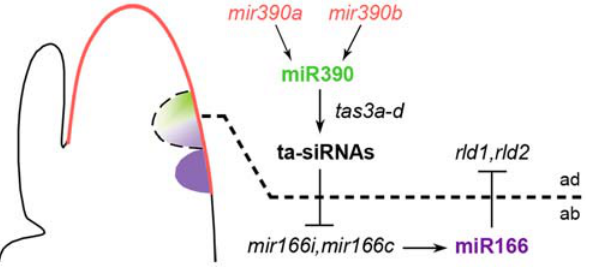
Figure 5. A model for the establishment of maize leaf polarity. The diagram on the left illustrates the spatial pattern of expression for both mir390 precursors as well as mature miR390 and miR166 in the SAM. The mir390 precursors accumulate in the L1 layer of the whole SAM (red). In contrast, mature miR390 (green) is present in both the L1 and underlying L2 layers, but just on the adaxial side of the incipient leaf. The adaxial expression of miR390 persists even in the abaxialized leaves of lbl1 mutants, demonstrating that this small RNA, which constitutes an upstream component in the maize adaxial-abaxial patterning network, maintains polar expression independent of the tas3 ta-siRNA pathway. MiR390 activity triggers ta-siRNA biogenesis on the adaxial side of the incipient primordium that indirectly restrict the expression of specific mir166 family members. Regulation of small RNAs in the ta-siRNA pathway at the level of biogenesis, stability, or possibly movement generates an inverse abaxial gradient of mature miR166 (purple) that delineates the expression of hd-zipIII genes, like rld1 and rld2 , to the adaxial side of the incipient leaf establishing organ polarity.